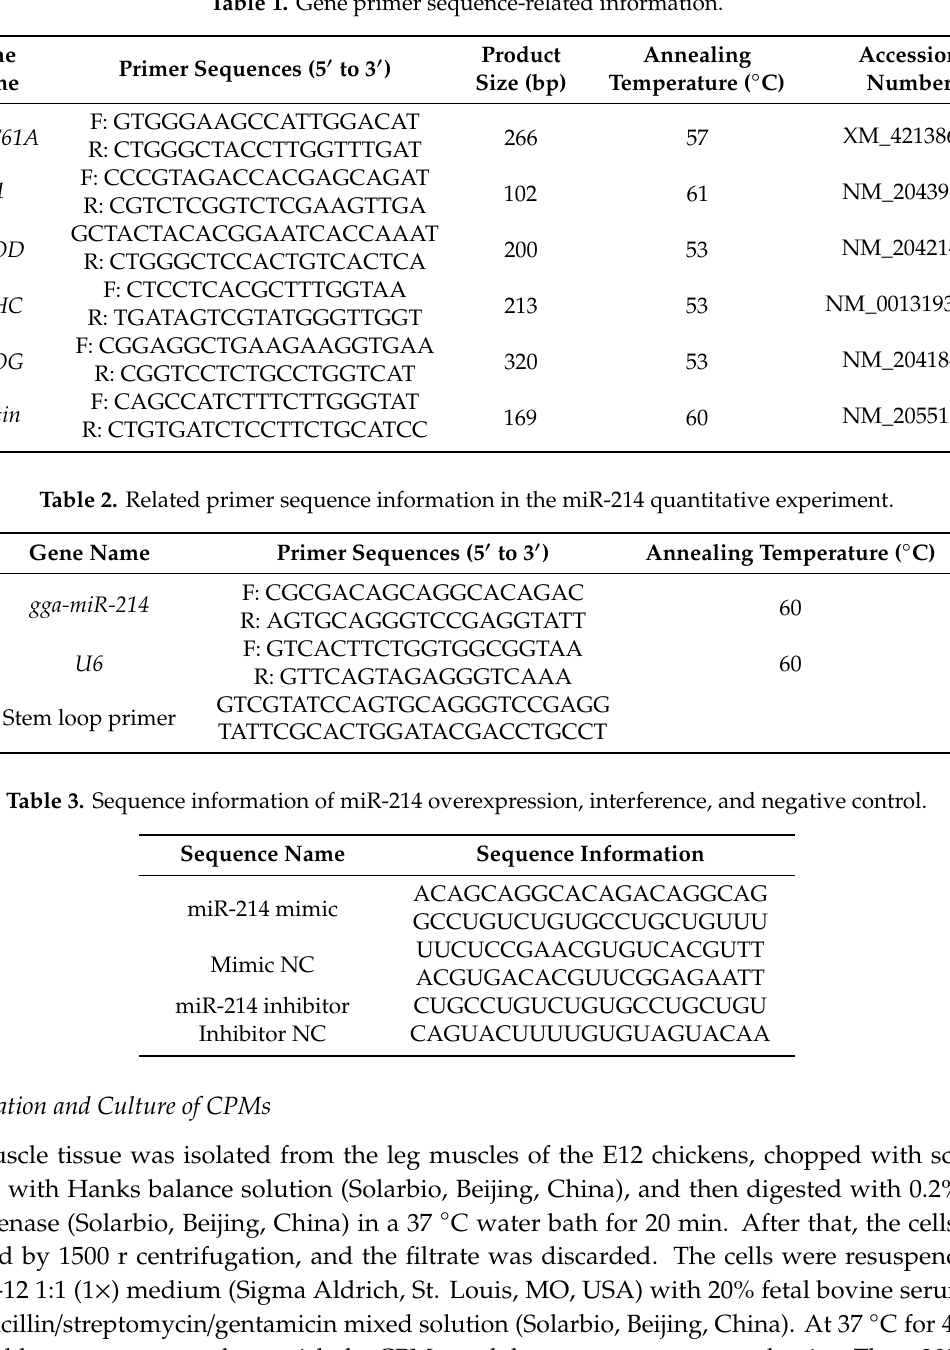
Table 1. Gene primer sequence-related information.